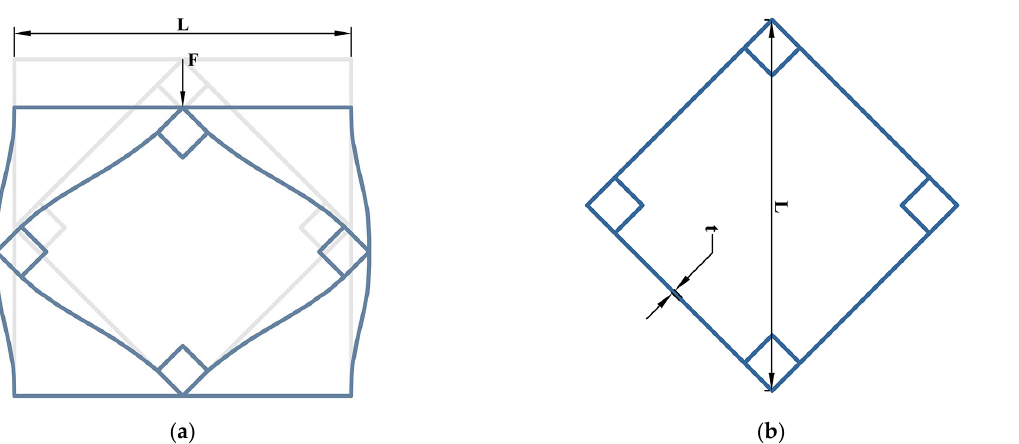
( b ) Figure 6. Mechanical properties of the rigid lattice. ( a ) The relationship between the elastic modulus and the cube side length of the rigid lattice (t = 2.5–4.5 mm); ( b ) The relationship between the Pois- son’s ratio the cube side length of the rigid lattice (t = 2.5–4.5 mm). 2.2.2. Compliant Cell As shown in Figure 3b, the compliant cell consists of six quadrilateral face elements, each consisting of four S-shaped beams. Figure 7a illustrates the deformation mechanism of the complaint unit cell. It also shows that the S-shaped beams suffer plane-bending deformation under an external load and feature a nearly zero Poisson’s ratio. If the cell size is constrained, the remaining geometric parameters of the compliant cell include the width of the S-shaped bulge, the height of the S-shaped bulge, and the beam section size. As shown in Figure 7b, we first investigate the relationship between the mechanical properties and the height of the S-shaped bulge. The height varied from H = 0.1 L to H = 0.2 L, and the beam section size and the width of the S-shaped bulge is constrained as 2.5 mm × 2.5 mm and 0.05 L, respectively. Figure 8 presents the influence of the height on the elastic modulus and Poisson’s ratio of the macro-lattice. It can be seen that as the height of the S-shaped bulge increases, the elastic modulus value decreases reversely. This indi- cates that increasing the height is beneficial to improving the deformation ability of the compliant cell. Meanwhile, the elastic modulus value barely changes with the increase of the cell numbers (n × n × n). This phenomenon can be attributed to the spring-like behavior